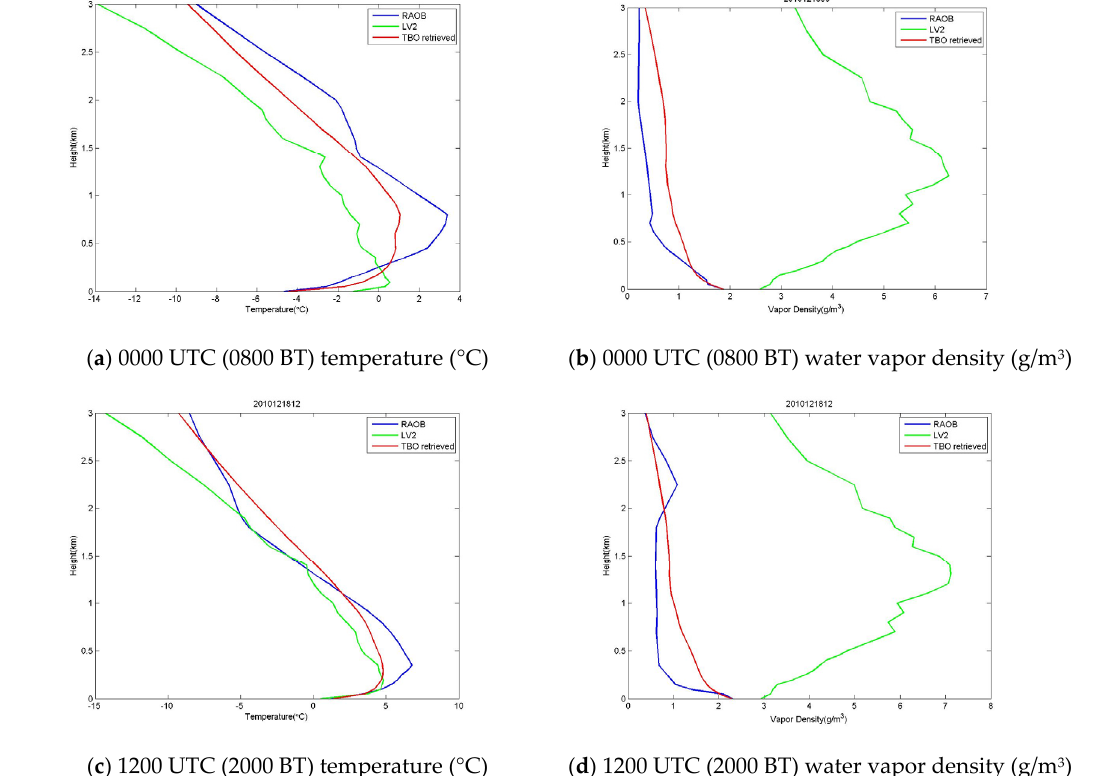
Figure 3. Temperature and humidity profiles on 18 December 2010, with intervals of 12 h: ( a ) 0000 UTC temperature; ( b ) 0000 UTC water vapor density; ( c ) 1200 UTC temperature; ( d ) 1200 UTC water vapor density.